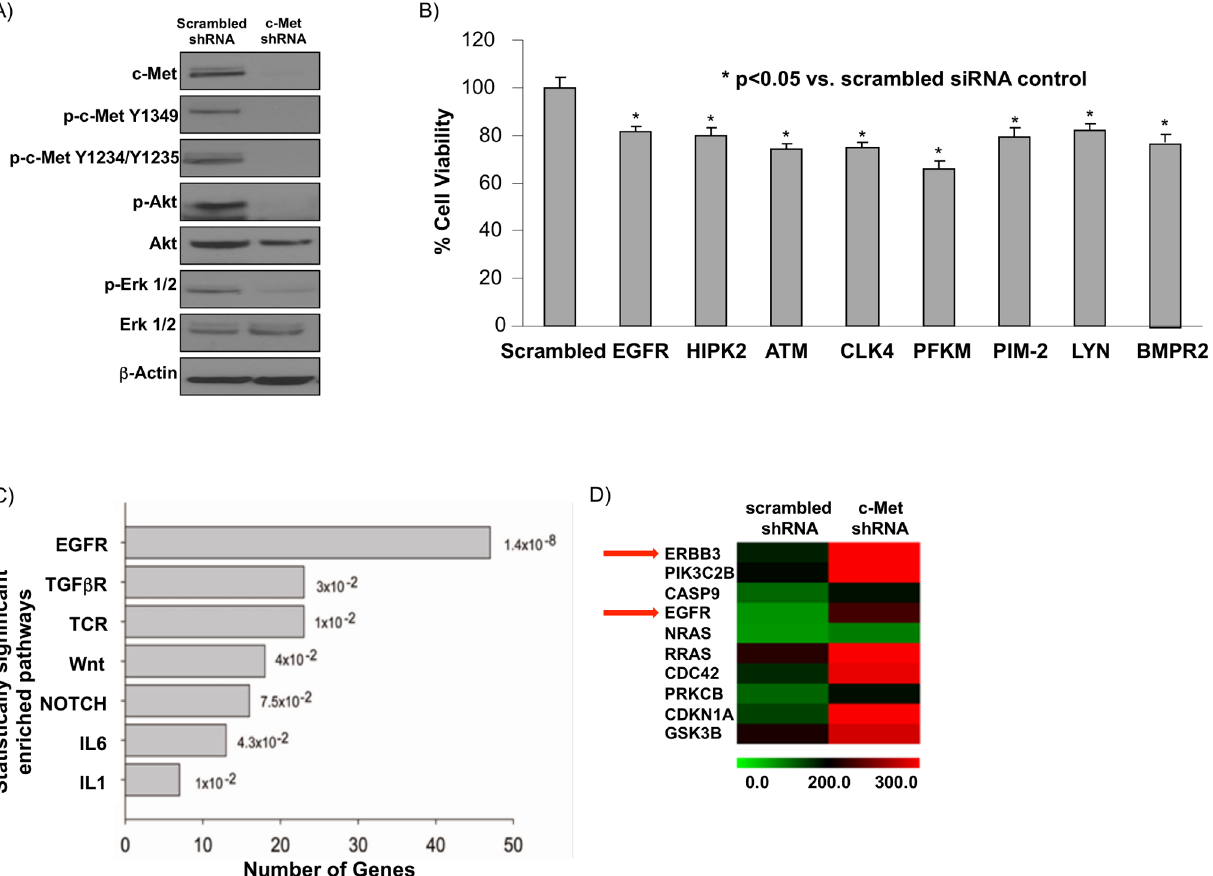
Fig 1. siRNA screening and microarray analysis of MHCC97-H liver cancer cell line stably transfected with c-Met shRNA reveals EGFR pathway as a putative survival pathway in HCC. A) c-Met shRNA was stably transfected into the MHCC97-H cell line, which has constitutive c-Met activity. After puromycin selection, immunoblot determined c-Met knockdown in a c-Met + HCC cell line suppresses downstream signaling (c-Met, Akt, and Erk1/2 phosphorylation) compared to MHCC97-H cells stably expressing a scrambled shRNA. B) An XTT assay was performed to confirm the eight targets from the siRNA screen that had the greatest effect on cell viability in MHCC97-H c-Met KD cells. 10 nM siRNA and 0.2 ul RNAiMAX were used to transfect MHCC97-H c-Met KD cells and cell viability was determined at 48 hours post transfection. C) Ingenuity pathway analysis was conducted to compare microarray gene expression between MHCC97-H c-Met knockdown (KD) cells and MHCC97-H cells stably expressing a scrambled shRNA. The top seven enriched pathways are shown. D) A heatmap of the subset of the EGFR pathway gene set that is differentially expressed by microarray (Illumina human gene chip). A statistically significant (p < 0.05) 1.4-fold or greater change in expression between c-Met shRNA and scrambled shRNA cell lines was considered differentially